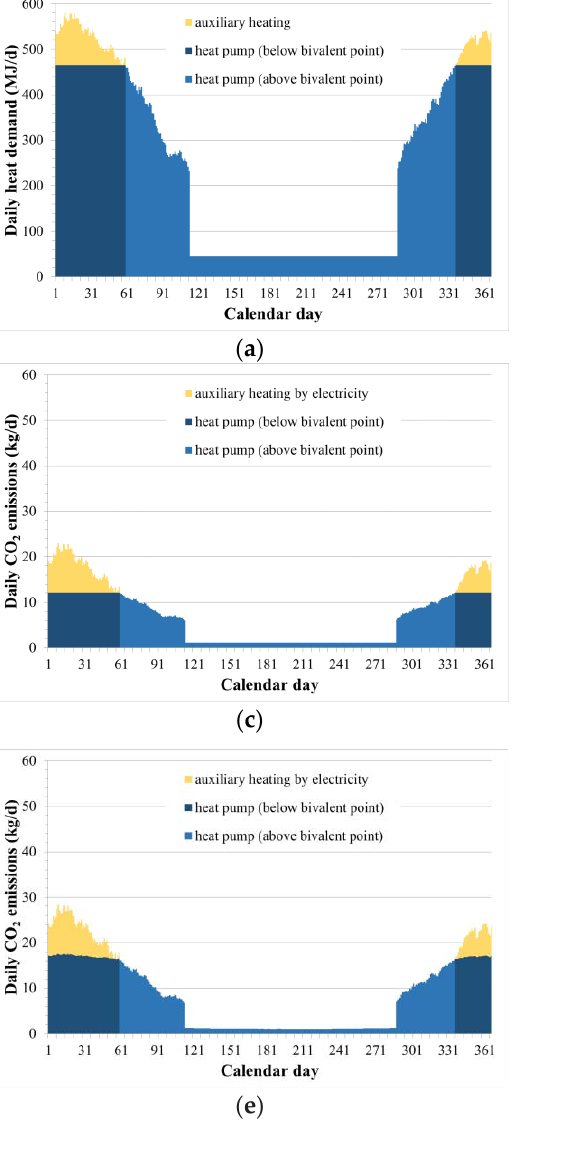
Figure 6. Daily heat demand and CO 2 emissions data of some studied systems with electricity as auxiliary heat: ( a ) heat demand in parallel mode (both GWSHPs and ASHPs); ( b ) heat demand in alternate mode (both GWSHPs and ASHPs); ( c ) CO 2 emissions in parallel mode, GWSHPs; ( d ) CO 2 emissions in alternate mode, GWSHPs; ( e ) CO 2 emissions in parallel mode, ASHPs; and ( f ) CO 2 emissions in alternate mode, ASHPs. Table 4. Absolute and specific CO 2 emissions in the studied bivalent systems, T B = 2 ◦